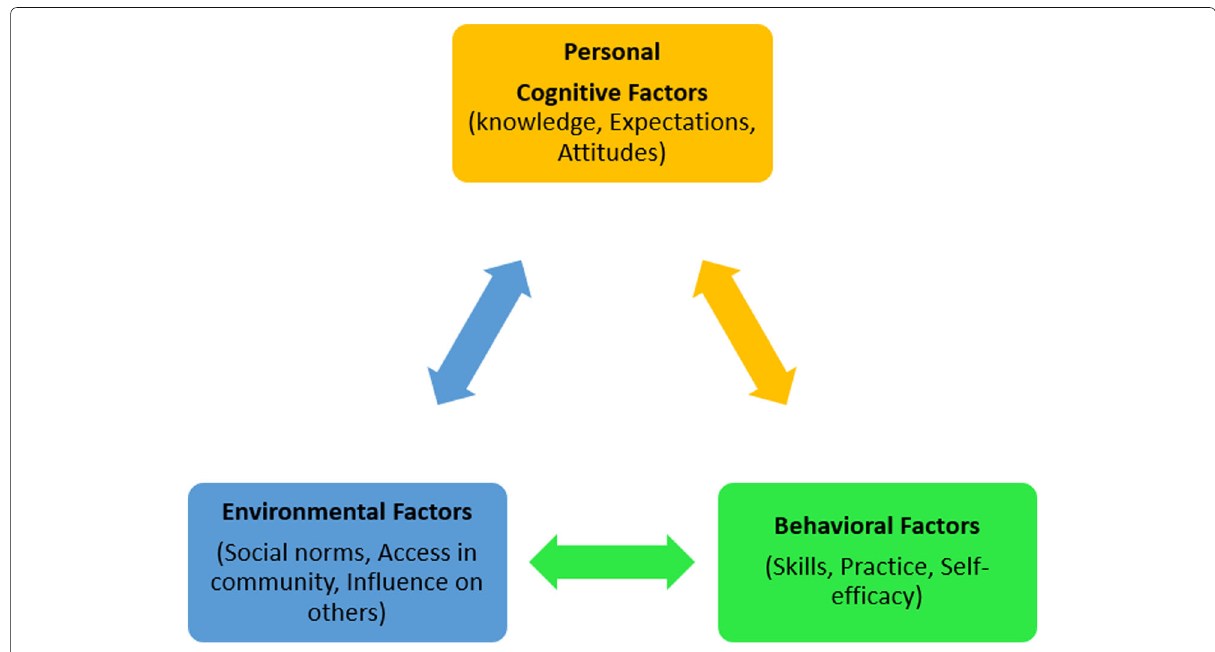
Fig. 5 Social Cognition Theory basic